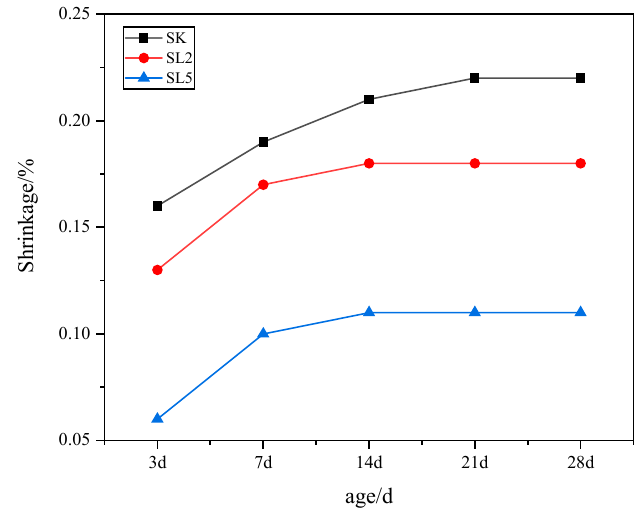
Figure 5. Hydraulic lime mortar blocks shrinkage rates.